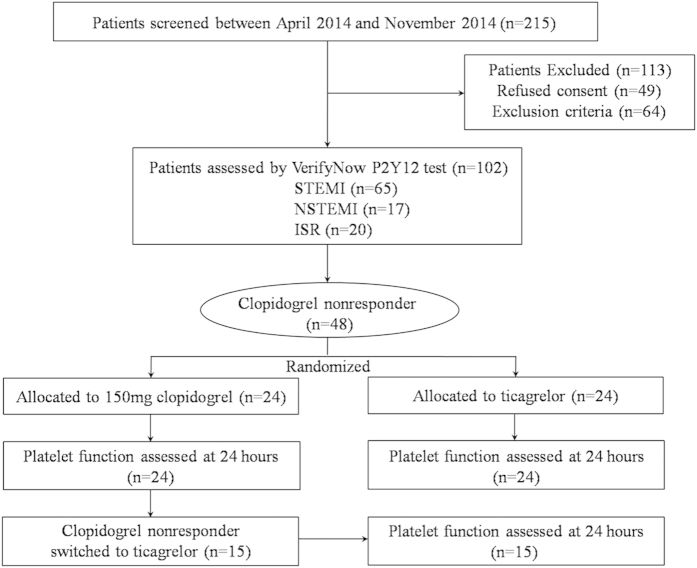
Patient flow chart.